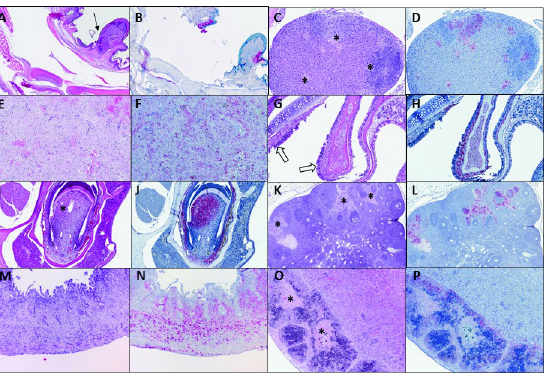
Fig 2. Representative histopathology and immunohistochemistry of VARV infection in humanized mice. A, B : Chronic skin ulceration over the hock, with epidermal hyperplasia (arrow, A) and VARV immunostaining in skin, tendon, and periosteum (hu-PBMC-11; low dose, day of death 21 dpi). C, D: Multifocal adrenal gland necrosis ( � , C) with VARV immunostaining (hu-BLT-5; high dose, day of death 13 dpi). E, F: Diffuse splenic necrosis with lymphoid depletion, fibrin, and hemorrhage; extensive VARV immunostaining in reticuloendothelial and mesenchymal cells (hu-CD34+-4; high dose, day of death 16 dpi). G, H : Nasal mucosa with submucosal edema and mild inflammation (open arrows, G); extensive VARV immunostaining (hu-PBMC-6; high dose, day of death 21 dpi). I, J: Tooth with dental pulp necrosis ( � , I); VARV immunostaining of pulp and periodontal ligament (hu-CD34+-9; low dose, day of death 20 dpi). K, L : Ovary with multifocal stromal and follicular necrosis ( � , K) and VARV immunostaining (hu- PBMC-10; low dose, day of death 21 dpi). M, N: Uterus with transmural necrosis and VARV immunostaining (PBMC- 5; high dose, day of death 13 dpi). O, P : Focal necrosis ( � , O) in renal subcapsular human fetal thymic graft, with extensive VARV immunostaining (hu-BLT-5; high dose,). A, C, E, G, I, K, M, O (hematoxylin-eosin); B, D, F, H, J, L, N, P (VARV immunohistochemistry, viral antigen labeling in red). Original magnifications: A, B, O, P (x50); C-J, M, N (x100); K, L (x200).